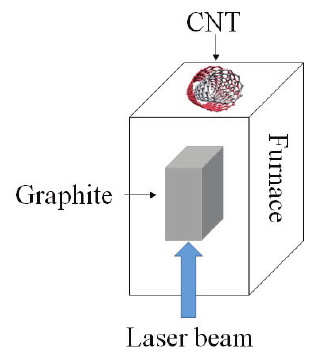
Figure 5. Schematic diagram presenting the pulsed laser ablation method. A graphite target in the reactor evaporates using a laser beam and the CNT layer forms on the surface at the end of the chamber.